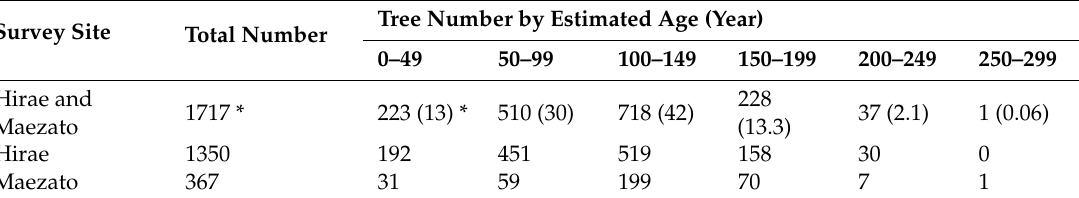
Table 2. Age distribution of Fukugi trees in Hirae and Maezato.